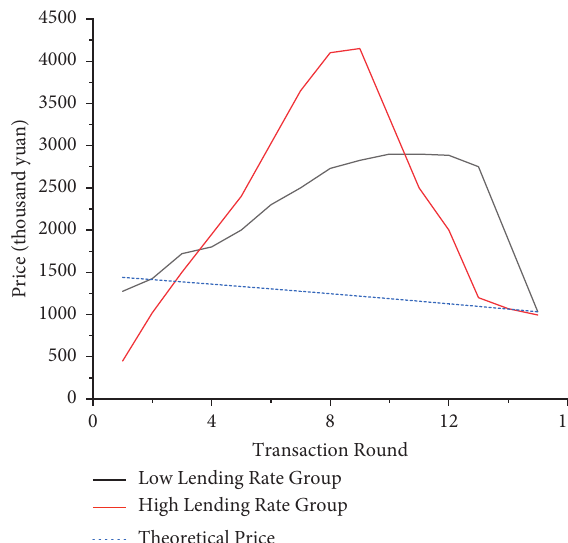
Figure 4: The average trading price and theoretical price of the two lending rate groups of each transaction